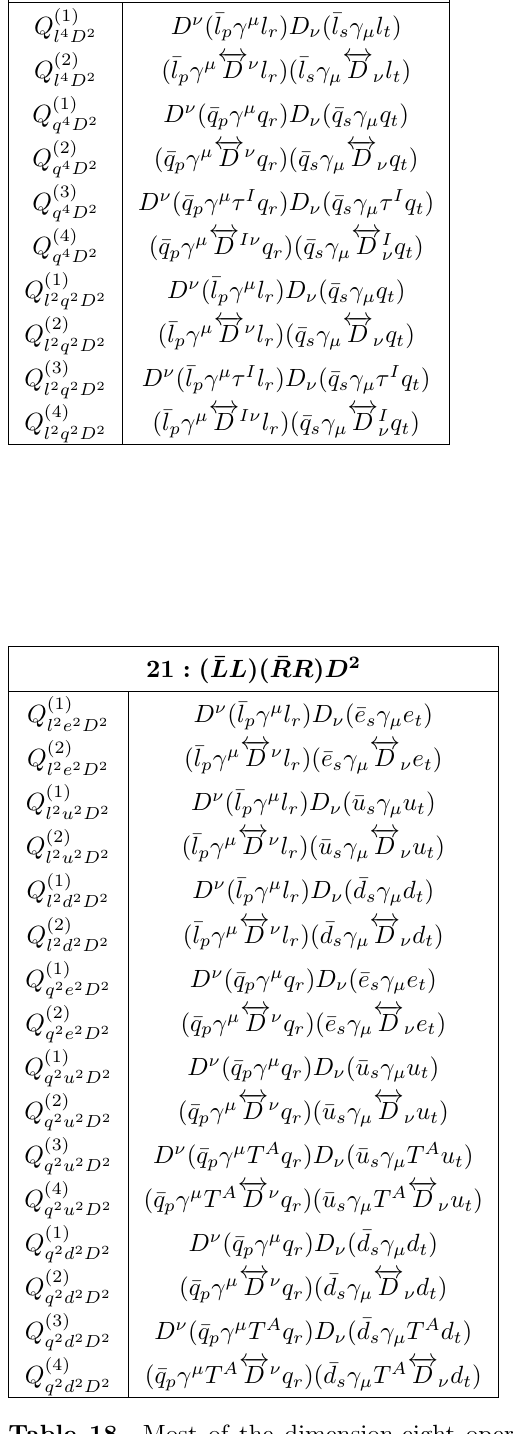
Table 18 . Most of the dimension-eight operators in the SMEFT of class-21, which are further divided into subclasses according to their chiral properties. See table 10 for the remaining class-21 operators. Operators with + h : c : have Hermitian conjugates. The subscripts p; r; s; t are weak- eigenstate